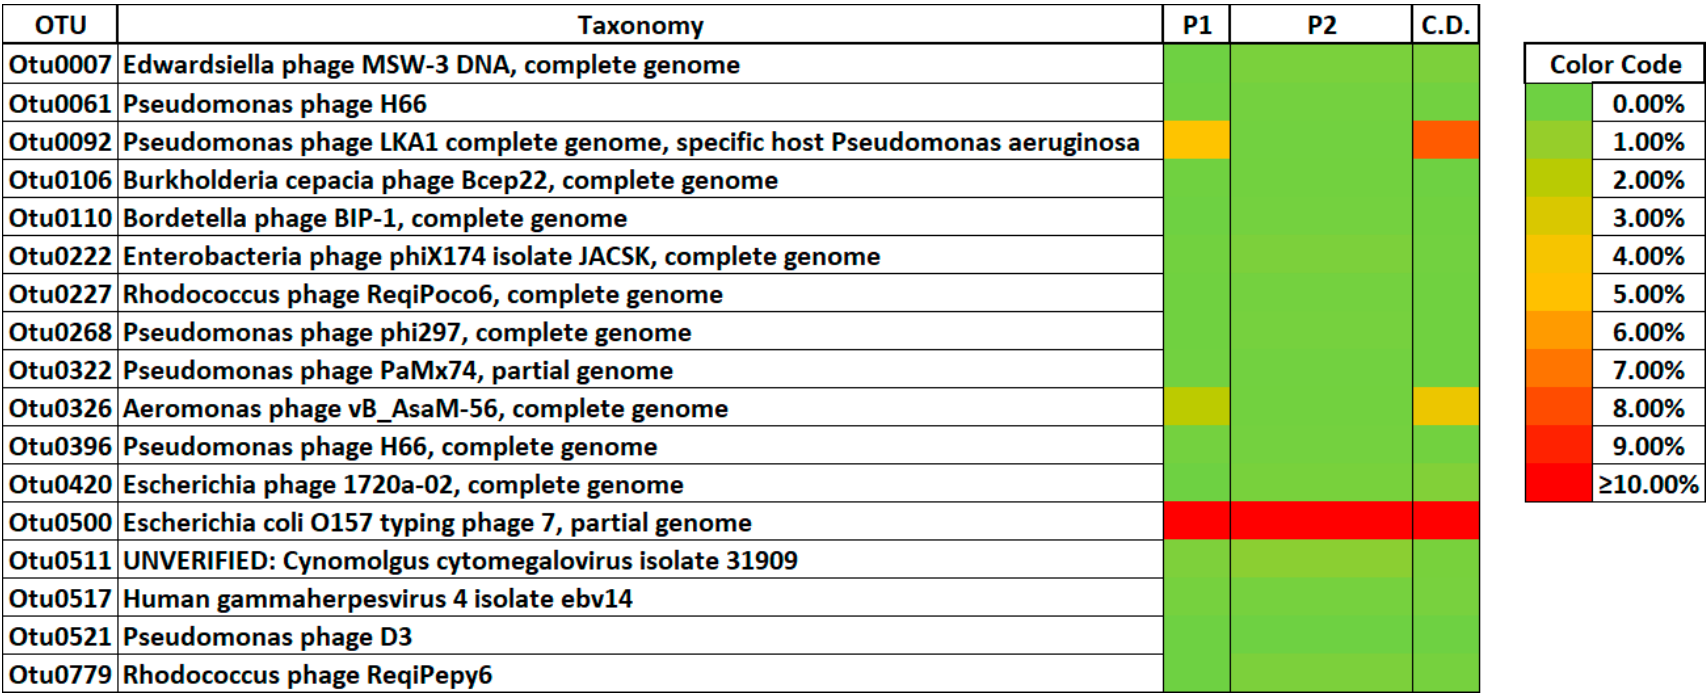
Figure 5. SIMPER analysis of influent water partition (P1) and mixed liquor, sludge, and effluent water partition (P2) of the viral community. C.D.: contribution to dissimilarity as per SIMPER analysis.